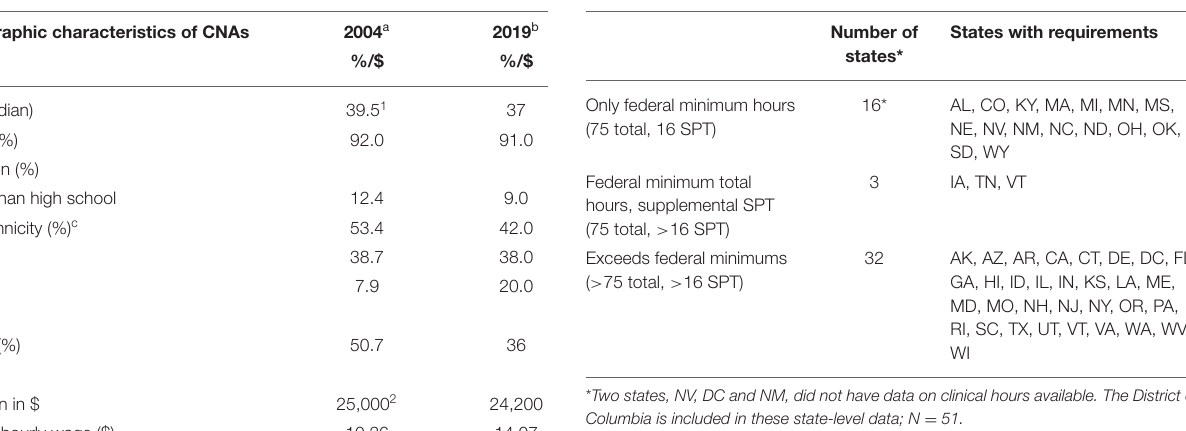
TABLE 2 | State- and DC-specific Certified Nursing Aide (CNA) training requirements.